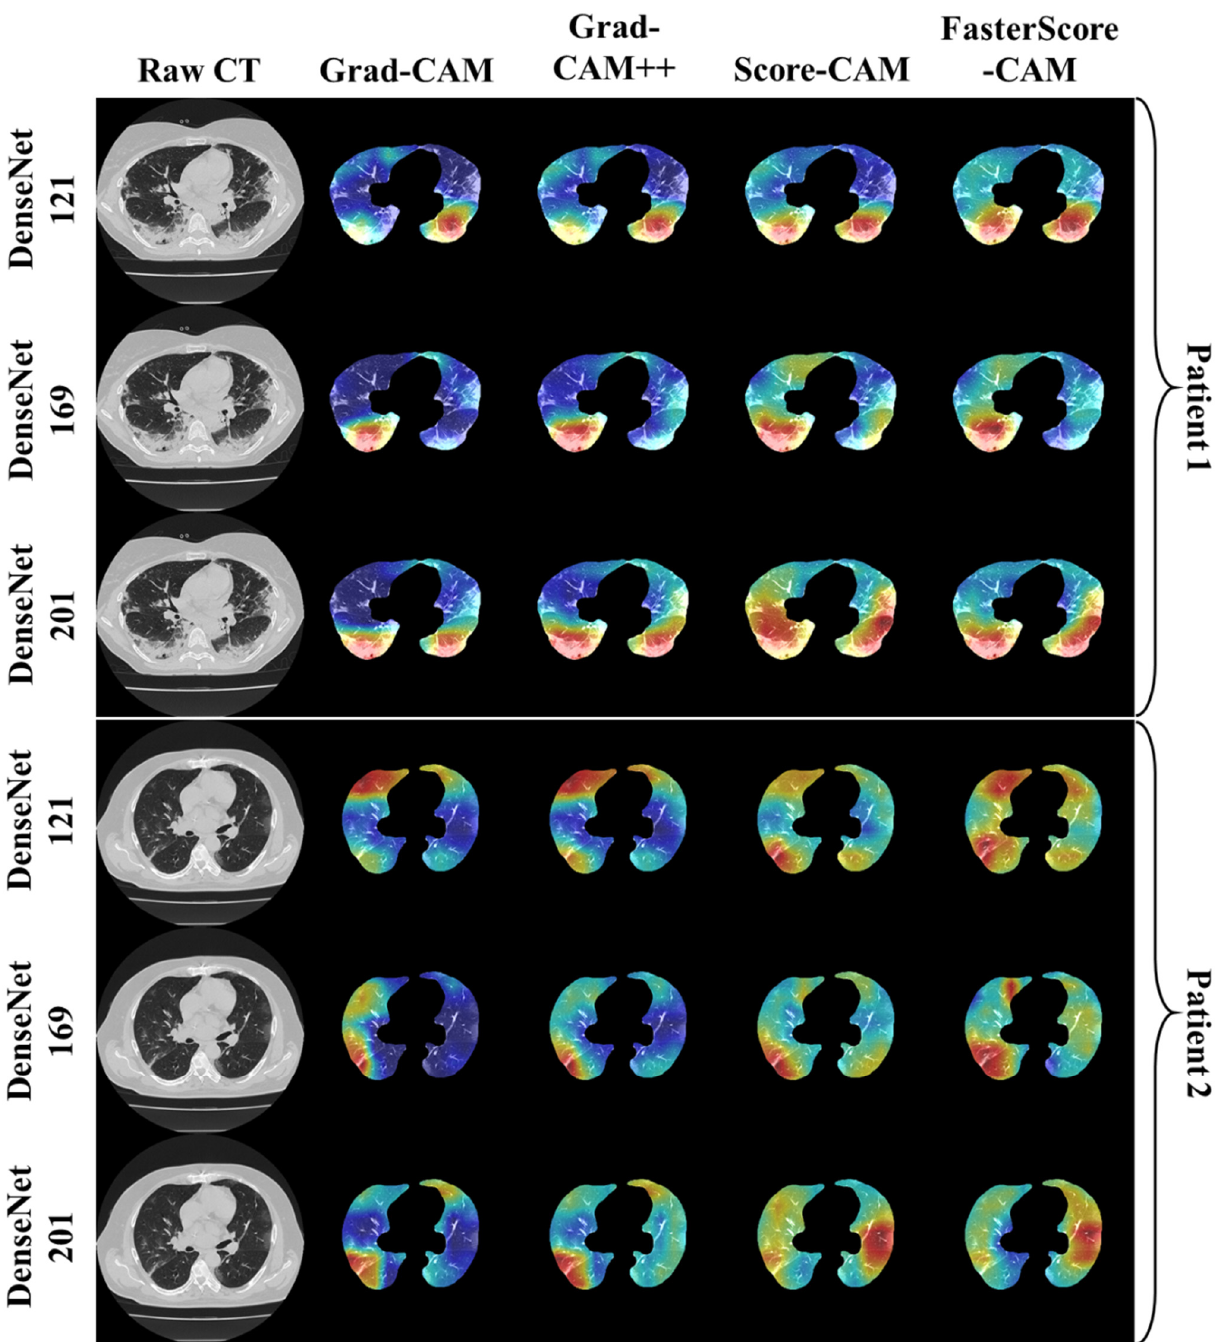
Figure 11. Heatmap using four CAM techniques using three kinds of DenseNet classifiers on COVID-19 lesion images. The top row is the CT slice for patient 1, and the bottom row is the CT slice for patient 2.